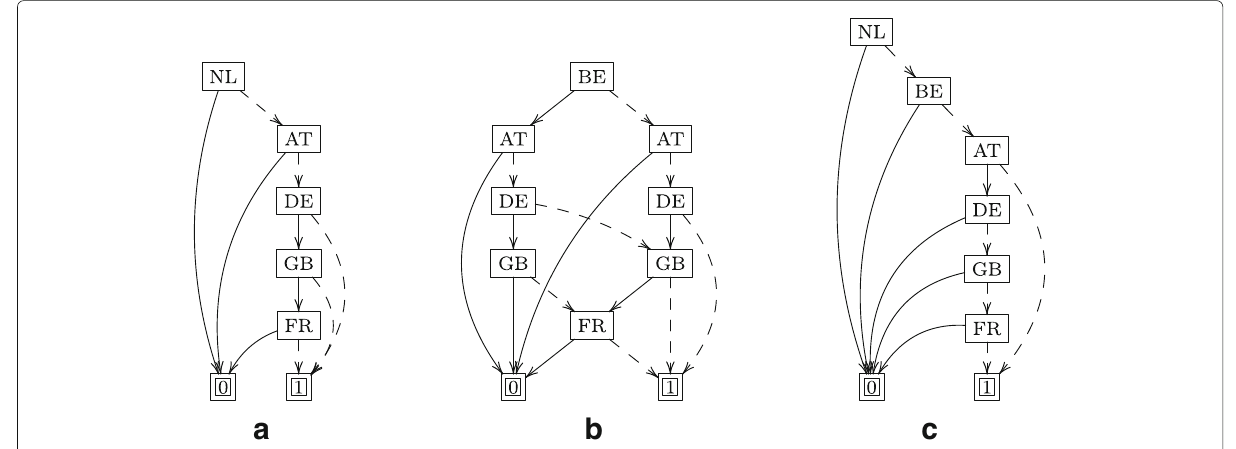
Fig. 3 BDDs ( e 1 , e 0 , e (cid:2) ) for the policy in “Problem statement” section. a e 1 . b e 0 . c e